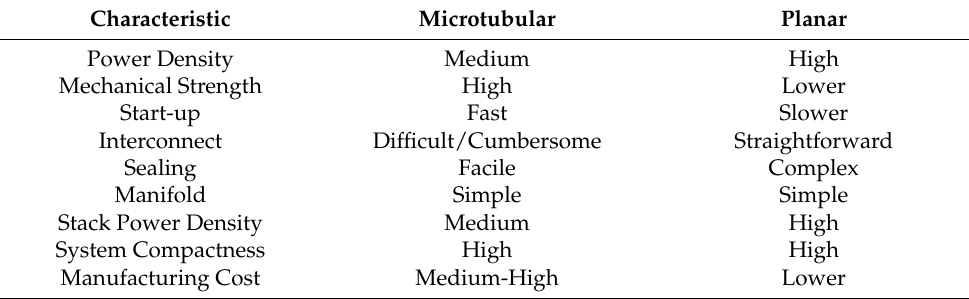
Table 1. Characteristics of micro-tubular ( µ T)-SOFC and planar SOFC.